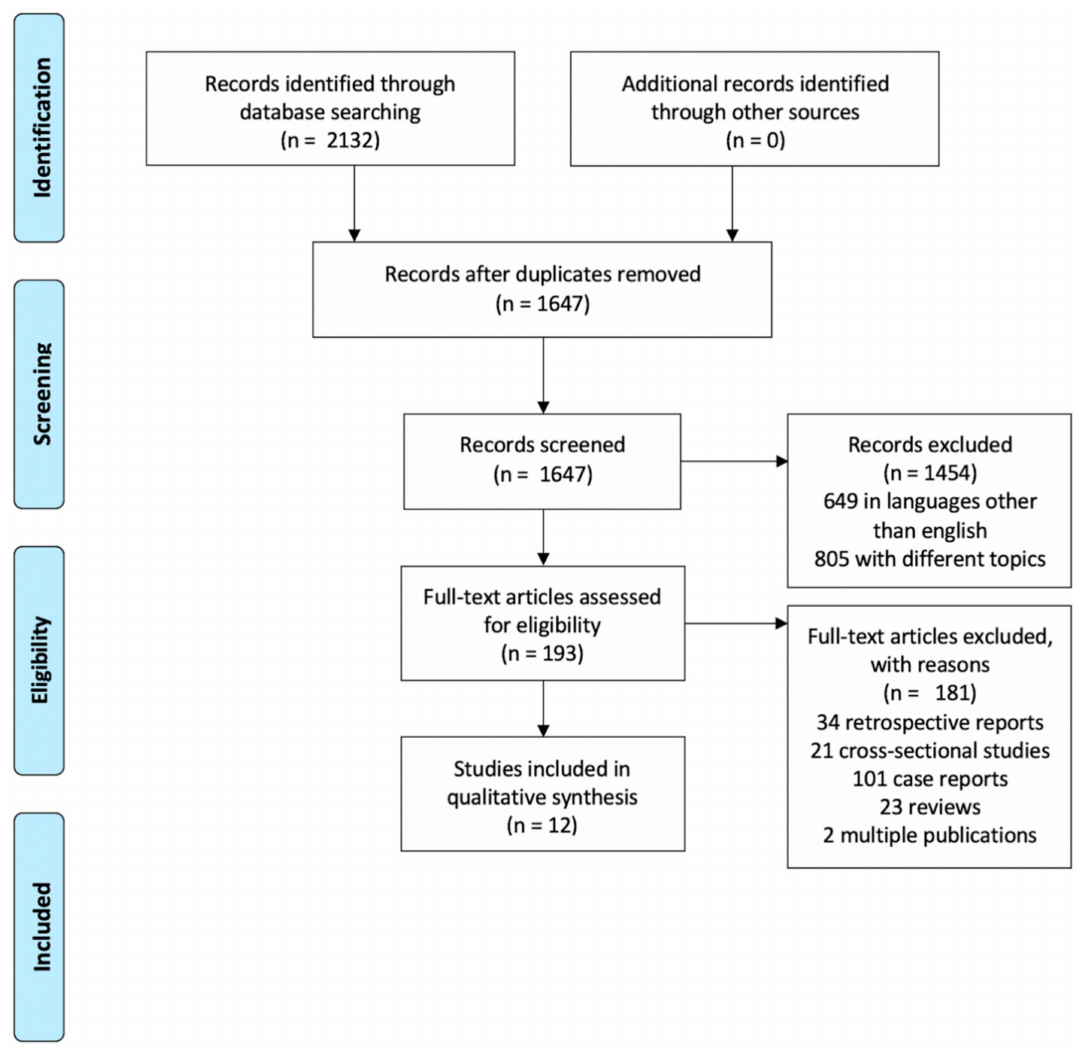
Figure 3. Flow chart for selection of